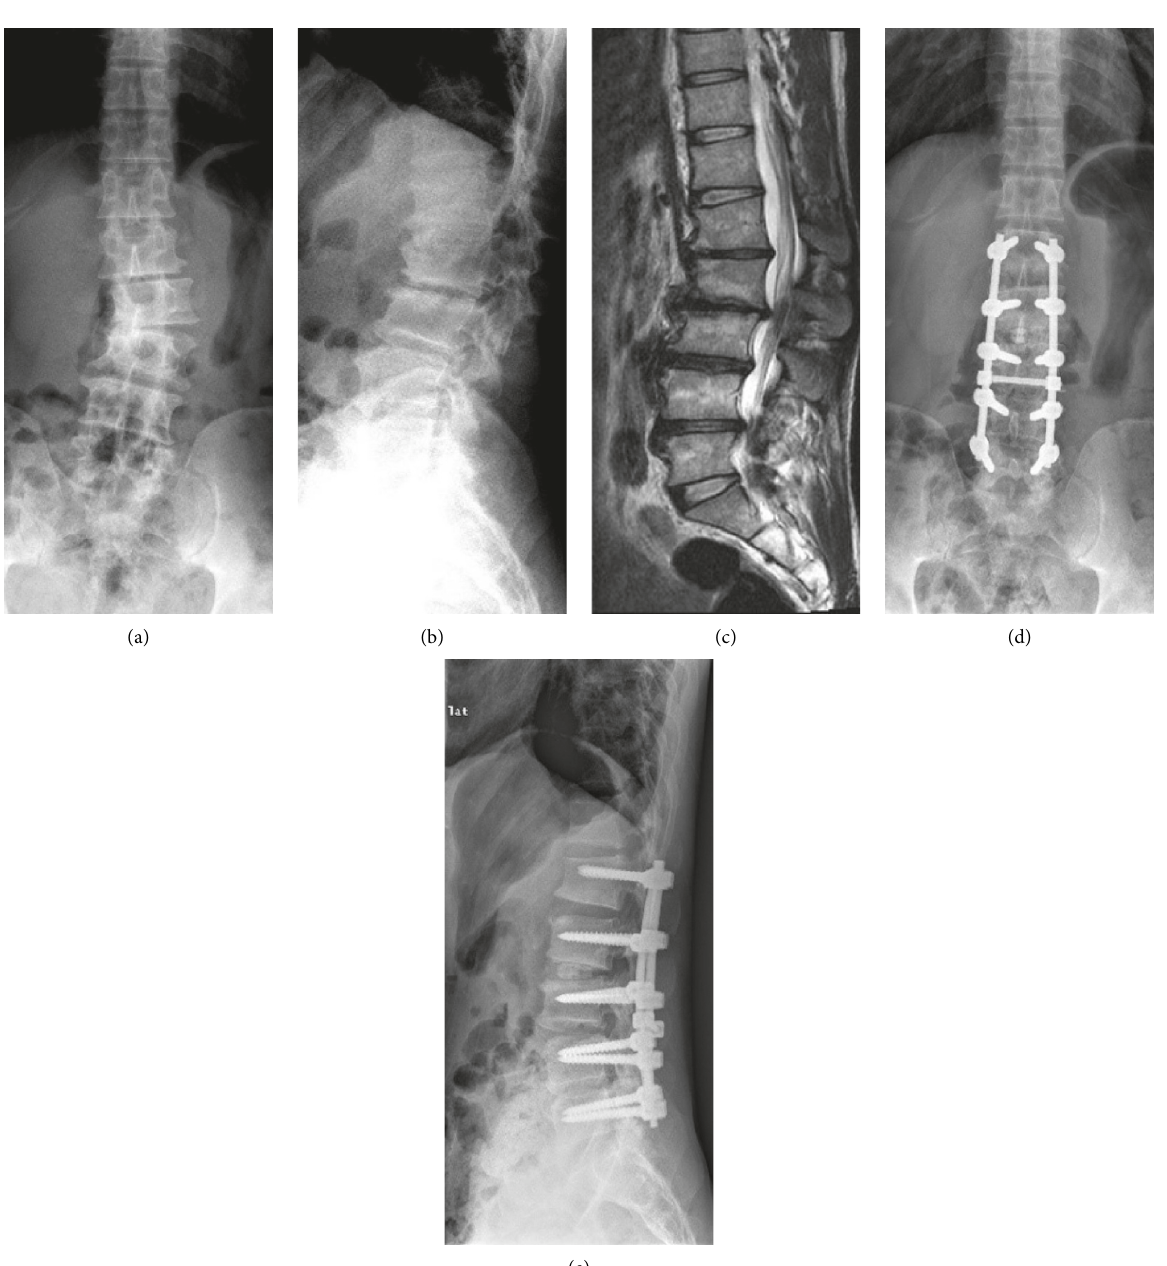
Figure 3: A 46-year-old man had spinal stenosis at L1–5 with DLS (a–c). She underwent fenestration decompression at L4-5, TLIF at L2-3, and posterolateral instrumented fusion at L1–5. The radiographs obtained 38 months after the operation showed stable scoliosis correction (d,